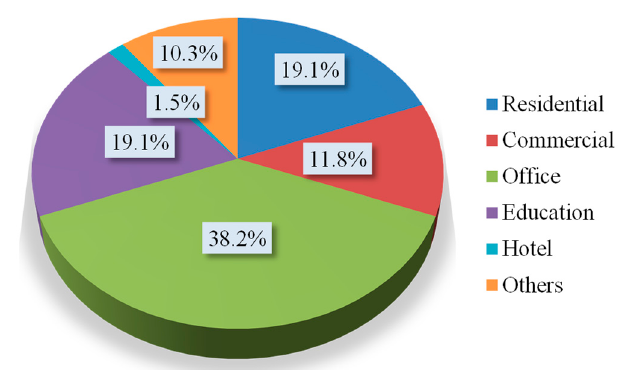
Figure 2. Proportion of LVDC buildings in different categories.